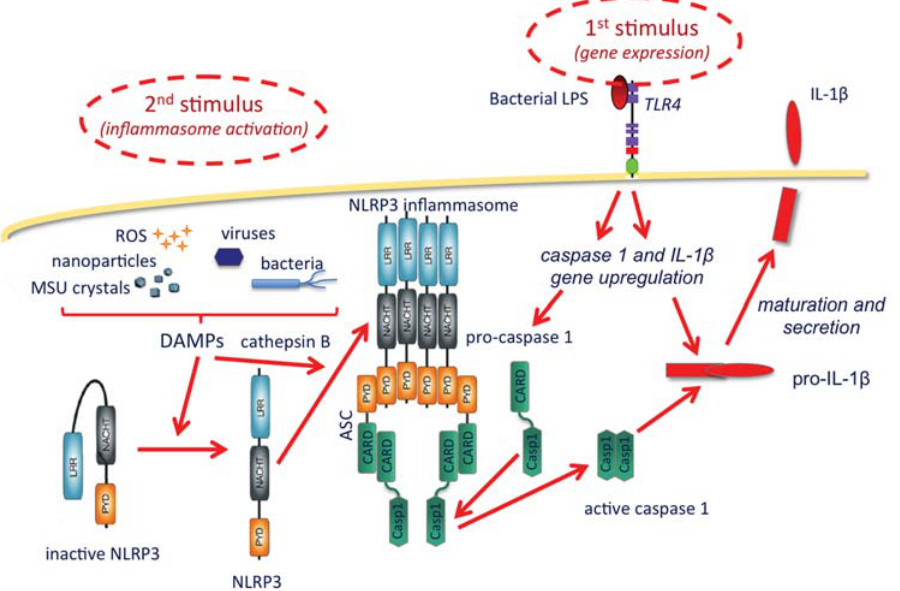
Figure 1. The NLRP3 activation and the production of IL-1(cid:2). A first stimulus, typically TLR agonists such as bacterial LPS ( upper right ), starts the activation by upregulating the expression of the genes encoding IL-1(cid:2) and caspase-1, which are synthesized as inactive precursors (pro-caspase-1 and pro-IL-1(cid:2)). The inflammasome is activated by a second type of stimuli ( upper left ), occurring intracellularly and being either endogenous or exogenous (particles and crystals of various origin, microorganisms, and reactive oxygen species), collectively dubbed danger-associated molecular patterns (DAMPs). These are able to NLRP3 molecules, an event facilitated by cathepsin B (released from ruptured